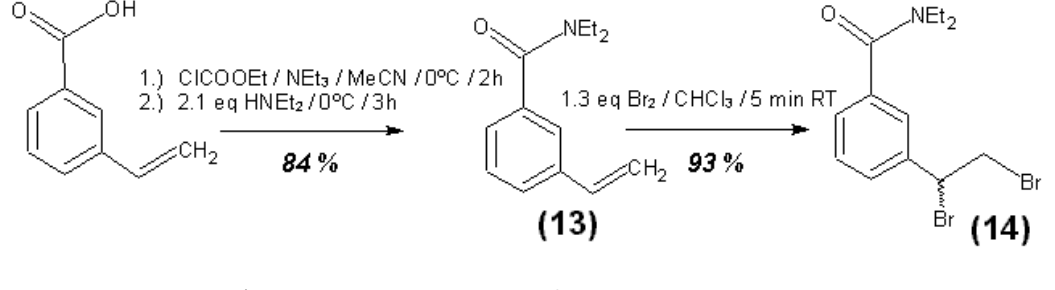
Figure 17. Synthesis steps for substances 13 and 14.